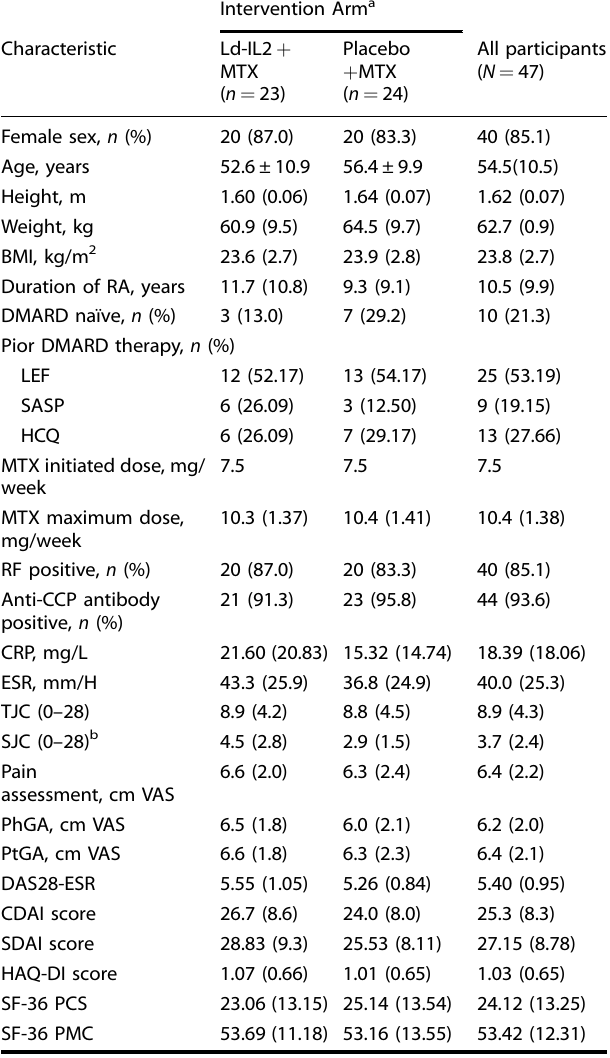
Table 1. Baseline characteristics of patients with